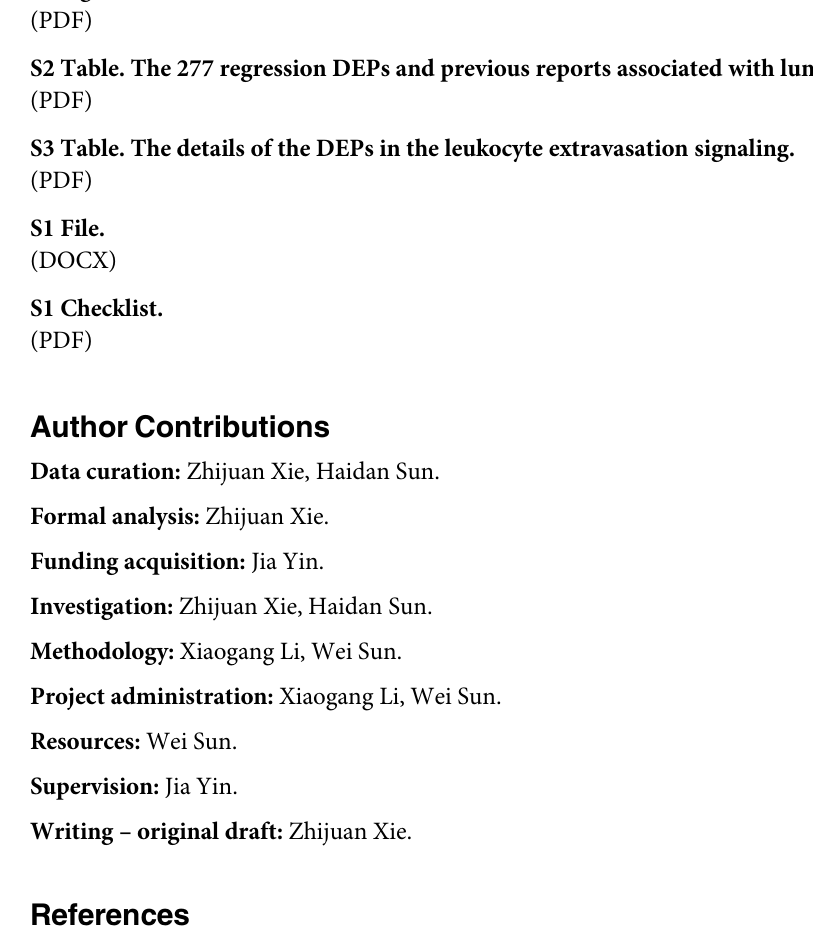
S1 Fig. GO analysis of 277 regression DEPs. A. The molecular function (MF). B. The biologi- cal process (BP). C. The cellular component (CC). S2 Fig. GO analysis: The whole mouse protein class as reference. (TIF) S3 Fig. The spectra of these DEPs in the leukocyte extravasation signaling pathway. MS/ MS data of represented peptides proteins (ITGAM, ITGB2, MMP12, NCF1, NCF2, NCF4, RAC2 and Vav1) were shown. A. The spectra of ITGB2 and MMP12. B. The spectra of VAV1 and NCF4. C. The spectra of NCF1 and RAC2. D. The spectra of NCF2 and ITGAM. (TIF) S1 Table. Significantly up- and down- regulated 277 DEPs with P value � 0.05 and fold change � 1.5 or � 0.67 both in asthma/control and asthma/SCIT. S2 Table. The 277 regression DEPs and previous reports associated with lung diseases. (PDF) S3 Table. The details of the DEPs in the leukocyte extravasation signaling. (PDF) S1